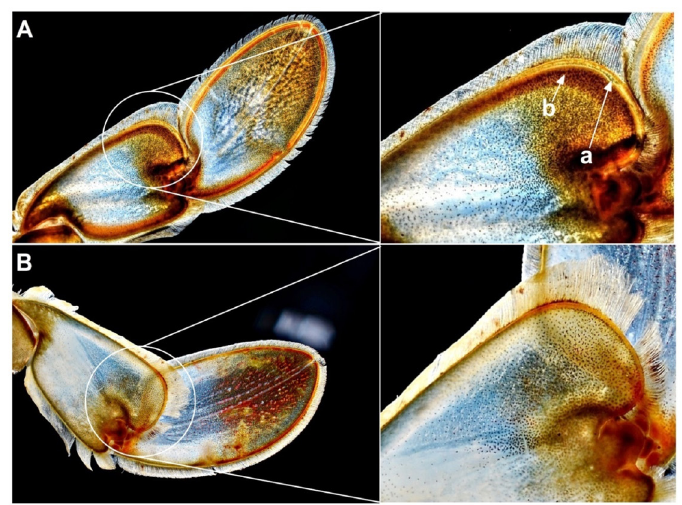
Figure 4. Presence of morphological signs of molt stages in Callinectes ornatus: white line along the distal edges of the pleopod (a); reddish color indicating the proximity of molt